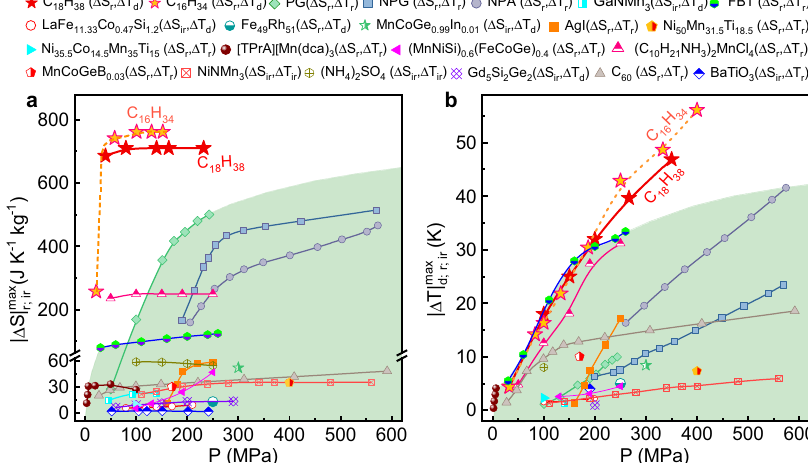
Fig. 2 Comparision of BC performance between C n H 2 n + 2 and the existing BC materials. The maximum magnitudes of isothermal entropy change ( a ) and adiabatic temperature change ( b ) as a function of pressure for C 18 H 38 and C 16 H 34 , are shown along with the reported BC materials. Here, the isothermal entropy change in references is mainly obtained by indirect or quasi-direct methods. According to different methods, reversible ( Δ S r ) and nonreversible entropy changes ( Δ S ir ) can be obtained in literatures. For the adiabatic temperature changes, some were measured by direct measurement ( Δ T d ). Others were estimated by the quasi-direct method, corresponding to either reversible ( Δ T r ) or irreversible values ( Δ T ir ). In general, | Δ S ir | and | Δ T ir |, which ignore the inherent thermal hysteresis effect, are larger than | S r | and | Δ T r |, while | Δ T d | is often less than the real value as it is dif fi cult to obtain a fully adiabatic